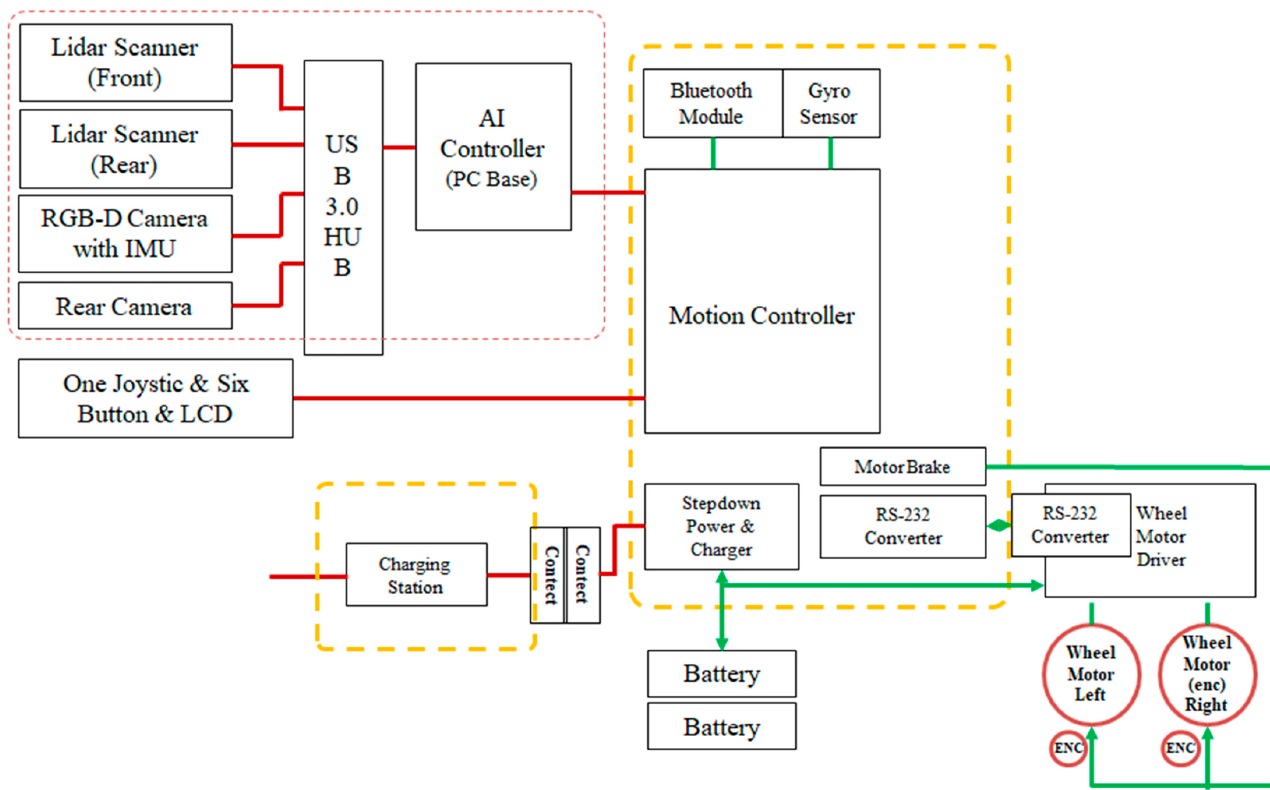
Figure 3. Schematic of the control unit of the electric wheelchair for autonomous driving.